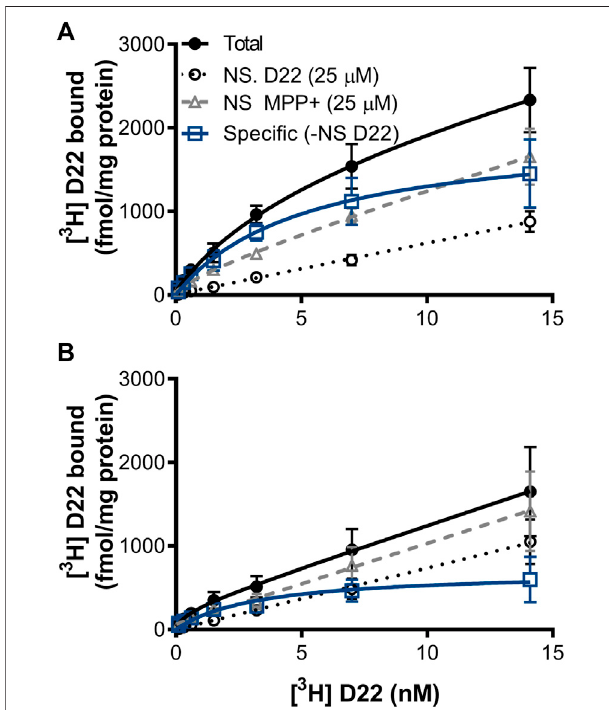
FIGURE 5 | [ 3 H] D-22 saturation in (A) zebra fi sh whole-brain versus (B) mouse hippocampus. A single high-af fi nity binding site for [ 3 H] D-22 with a K D of 5 ± 2.5 nM and Bmax of 1974 ± 410 fmol/mg protein was found in whole zebra fi sh brain, and a K D of 3.3 ± 2.3 and Bmax of 704 ± 182 fmol/mg protein in mouse hippocampus, respectively, with non-speci fi c de fi ned by 25 μ MD-22.Bindingof[ 3 H]D-22waspartiallyblockedbyMPP+, n =3.Mean and S.E.M. are